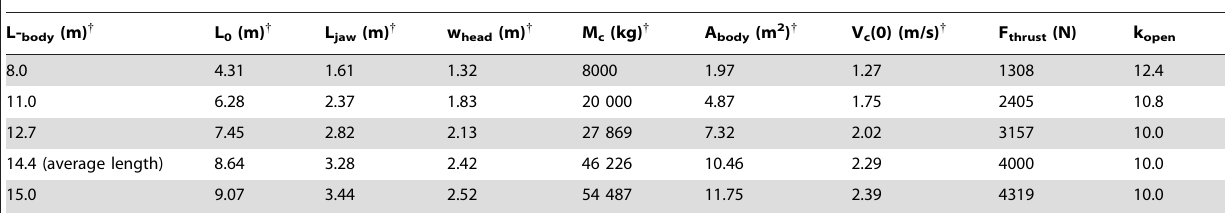
Table 3. BLF3 simulation inputs – humpback whales.